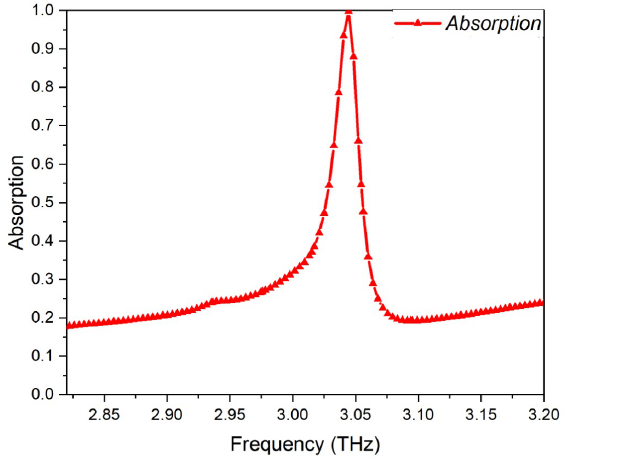
Figure 2. Absorption spectrum of the proposed structure.